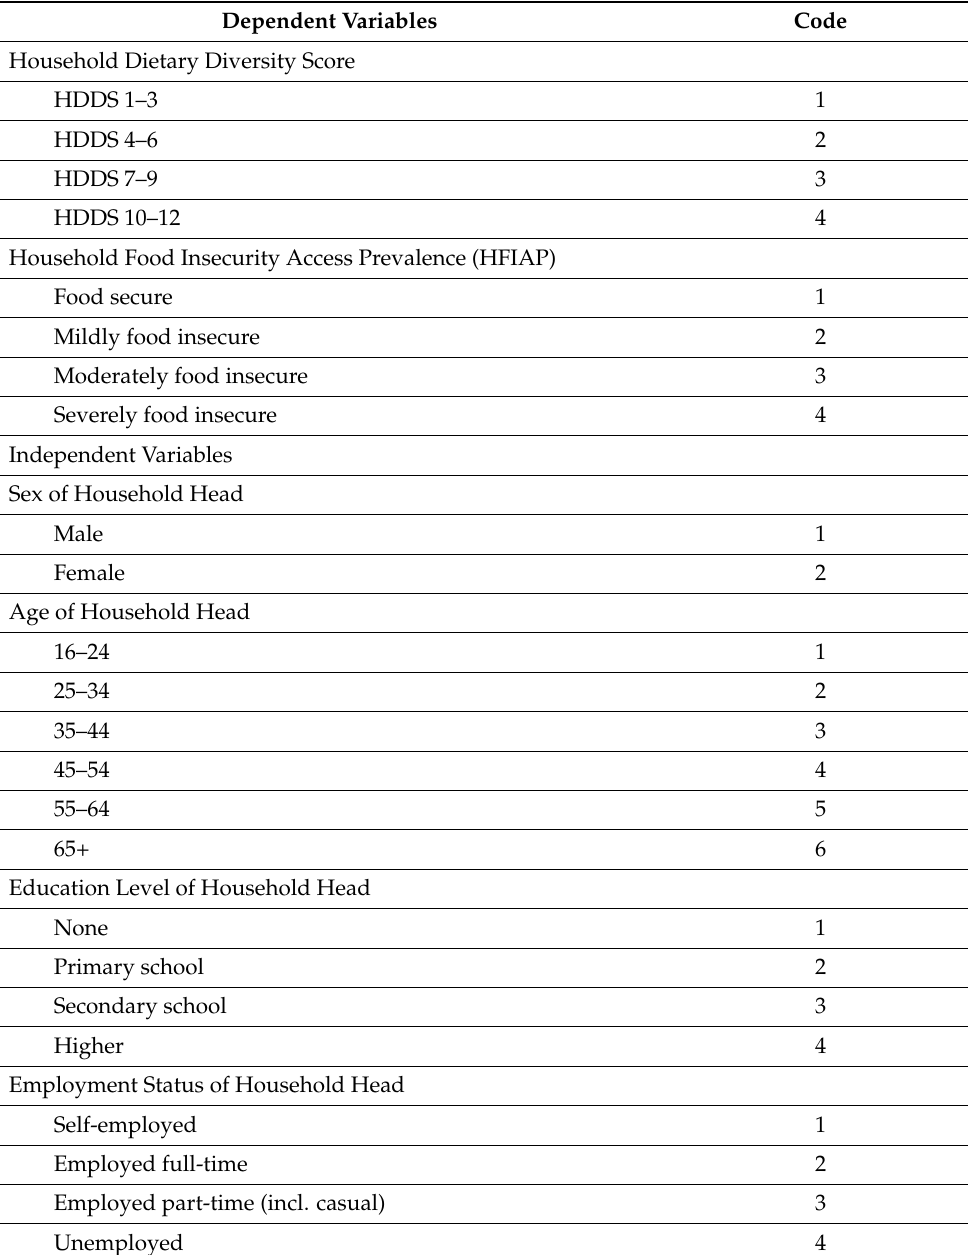
Table 3. Variables used in